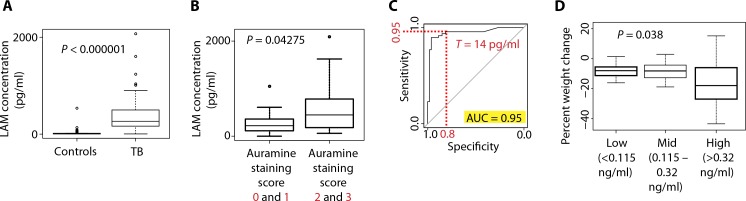
Urinary LAM concentration predicted pulmonary TB and correlated to mycobacterial burden and weight loss. (A) Box plot of the intensities of LAM in the urine of HIV-negative/TB-positive patients versus controls collected in endemic areas (Wilcoxon signed-rank test). (B) Box plot of the intensities of LAM in the urine of HIV-negative/TB-positive patients stratified on the basis of the auramine staining (low amount of microorganism, scores 0 and 1; high amount of microorganism, scores 2 and 3; Wilcoxon signed-rank test; n = 42). (C) Receiver operating characteristic analysis of the LAM intensity data. AUC, area under the curve. (D) Ordinal regression analysis shows statically significant correlation between the concentration of urinary LAM and the loss of body mass (P = 0.038, n = 37).